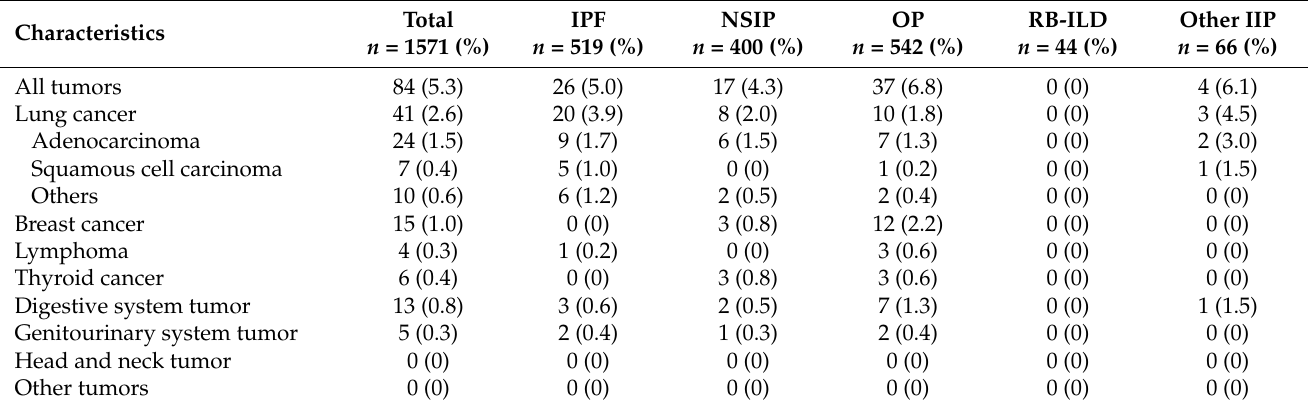
Table 5. Malignancies in various subtypes of IIP.